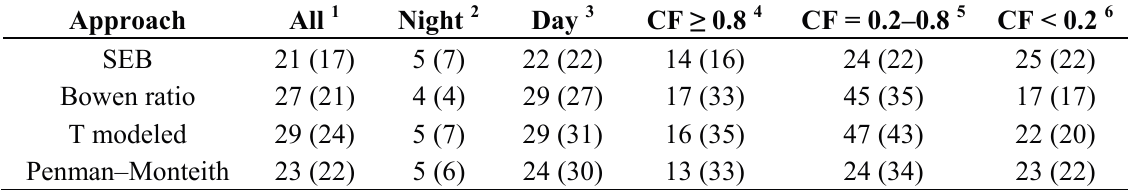
Table 3. Root mean squared error and mean absolute error (in parentheses) calculated for the difference found among eddy covariance-based measurements and model estimates of .; CF = cloud fraction, df = degrees of freedom. the latent heat flux using T rad,WE